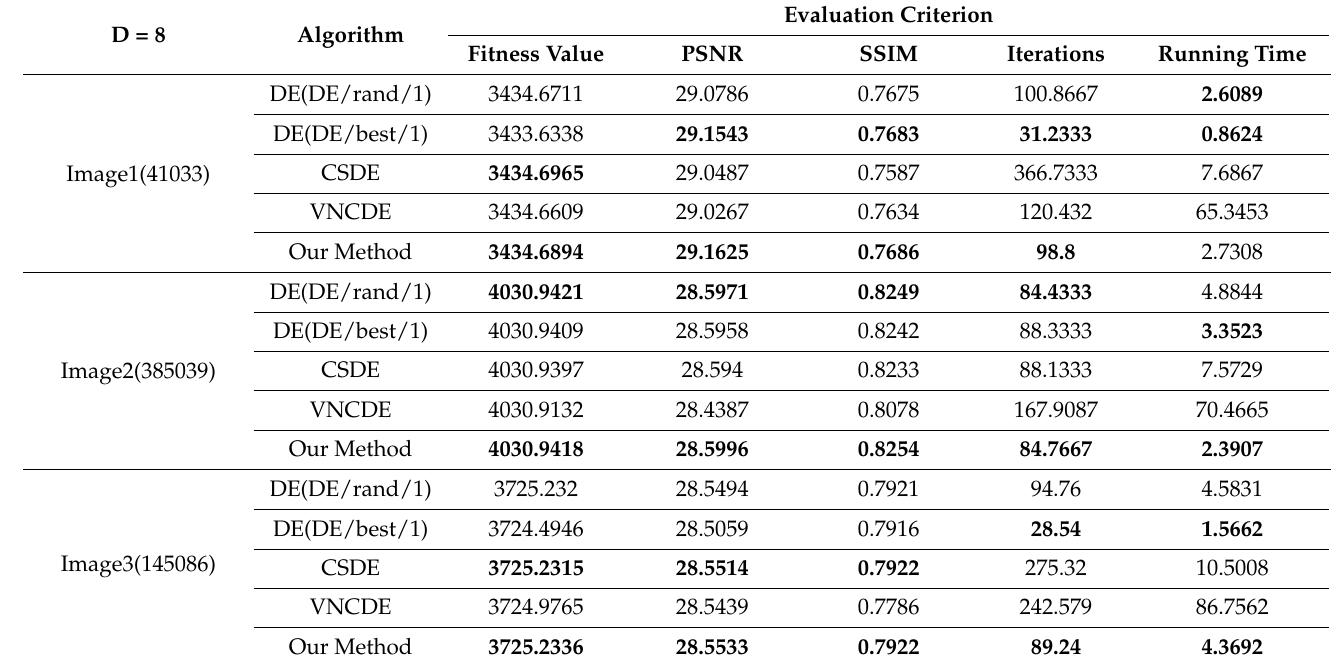
Table 4. Results comparison of five algorithms for segmentation of images 4–6 on different criteria when D = 8.